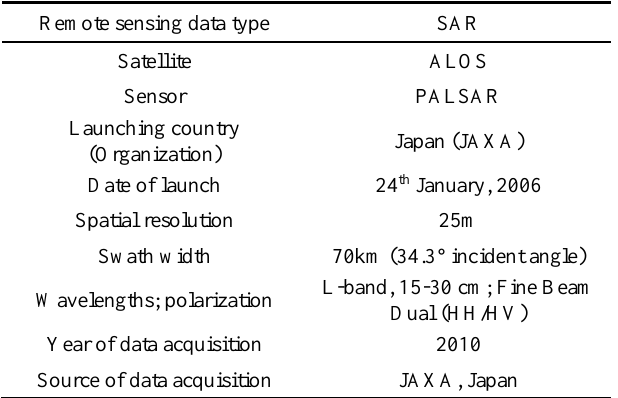
Table 1. Satellite data specifications